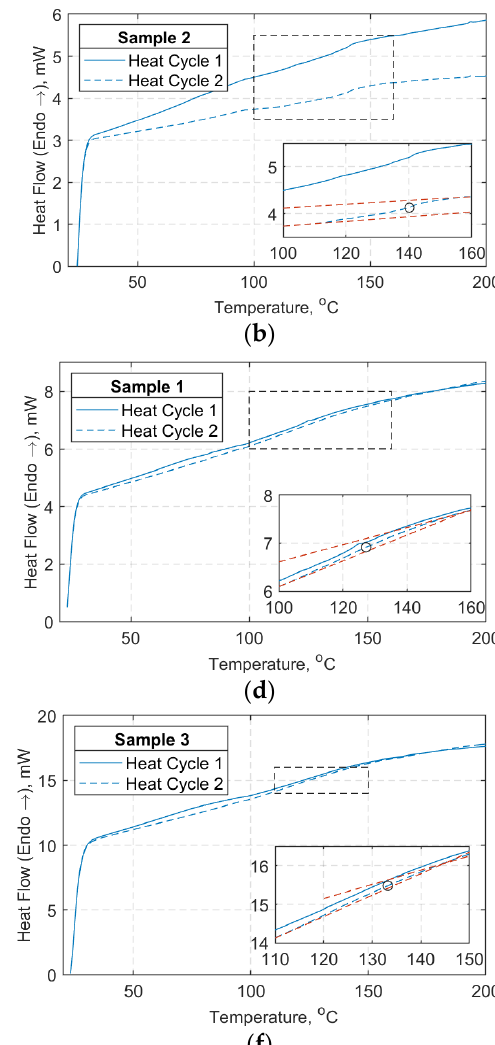
± 0.0001 scale accuracy; fiber density: 1.79 g/cm 3 ; epoxy density: 1.17 g/cm 3 . The DSC results were all processed in MATLAB R2019a following ASTM D3418-15 standard [38]. In Figure A1, the extrapolated onset and end temperatures are indicated with dashed (red) lines, and the glass transition (midpoint) temperature is the circled value in the zoomed region on the bottom right corner.